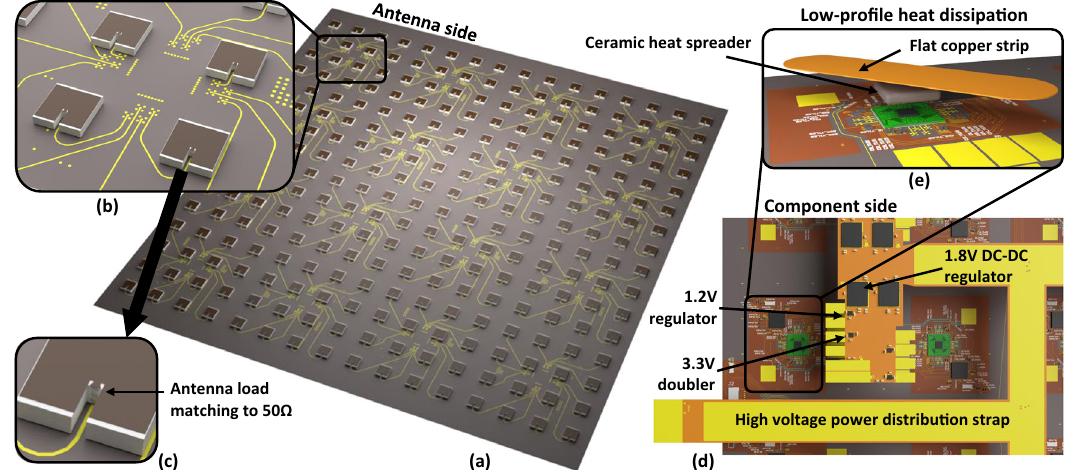
Fig. 5 Flexible and robust active antenna design. a Flexible sheets boards with ( b ) Discrete patch antennas. c The antenna feed via is used for impedance matching. d High voltage (up to 6 V) power delivery strap with local voltage regulator. e Low-pro fi le heat